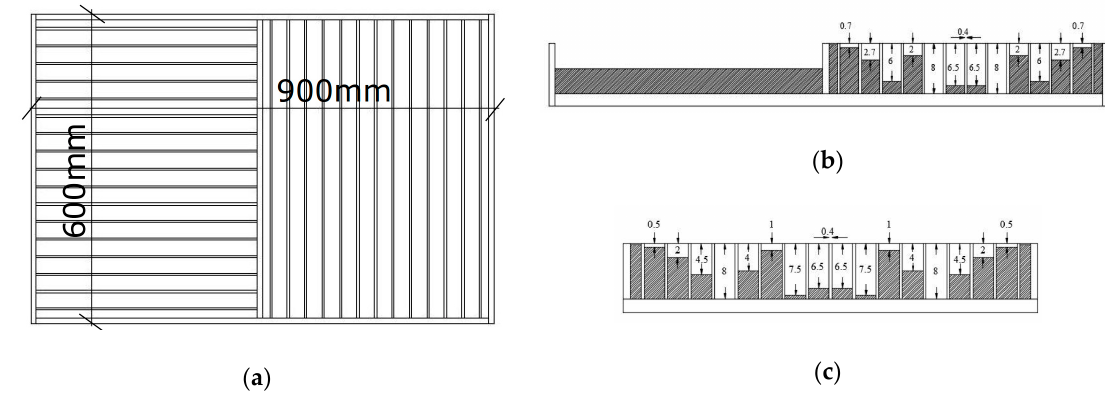
Figure 1. Quadratic residue diffuser (QRD) used during the experimental measurements: ( a ) elevation; ( b ) horizontal section; ( c ) vertical section. All the numbers are in mm.